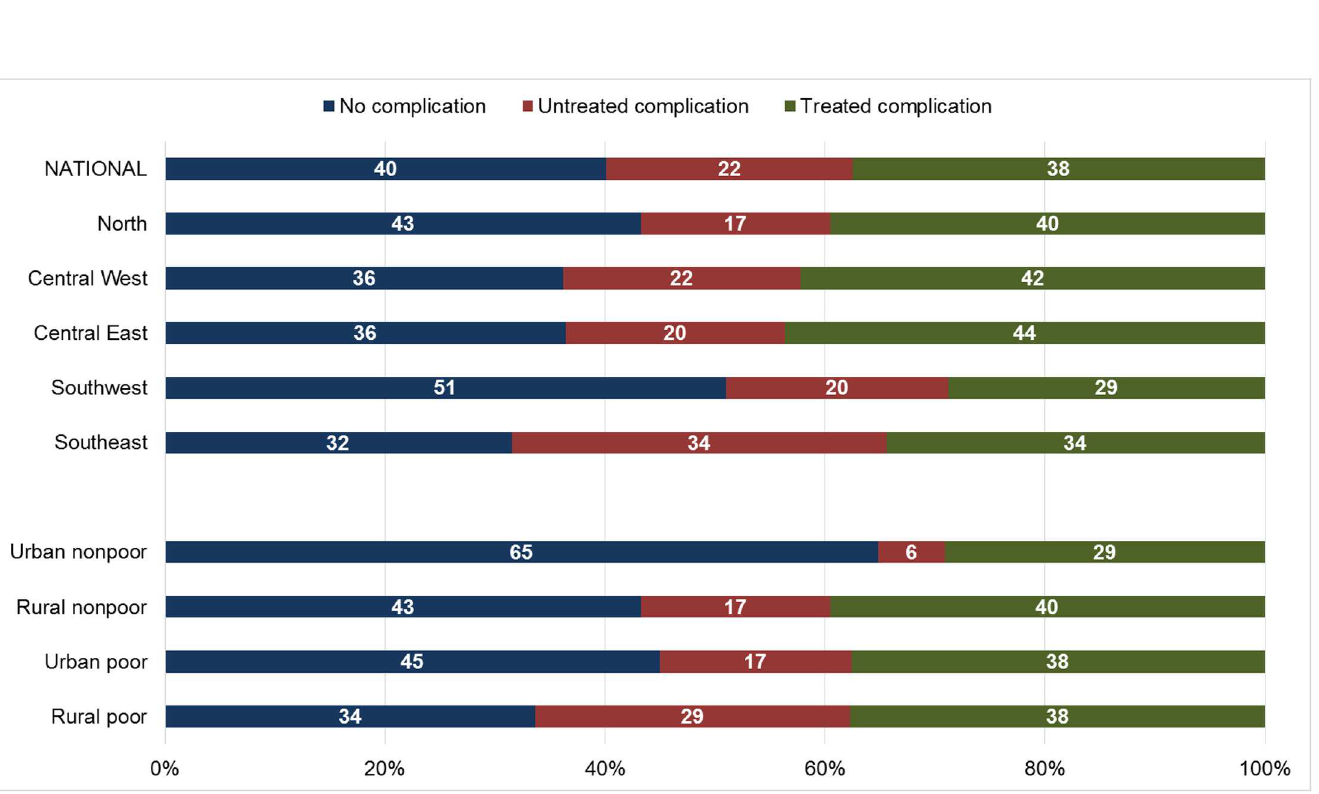
Fig 3. Estimated percentage distribution of abortions, by outcome, according to zone and women’s characteristics, Knowledgeable Informant Survey, Malawi